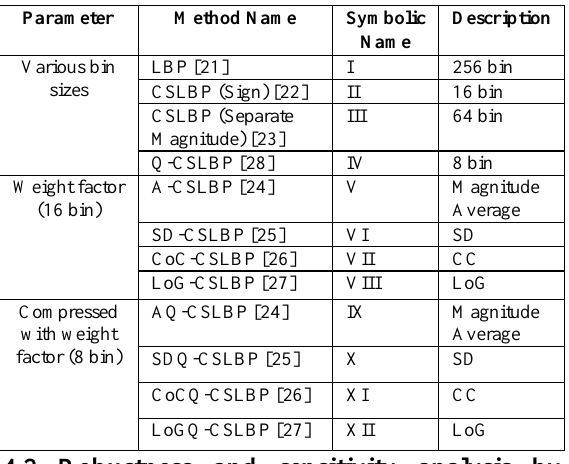
Table 3. Symbolic names for